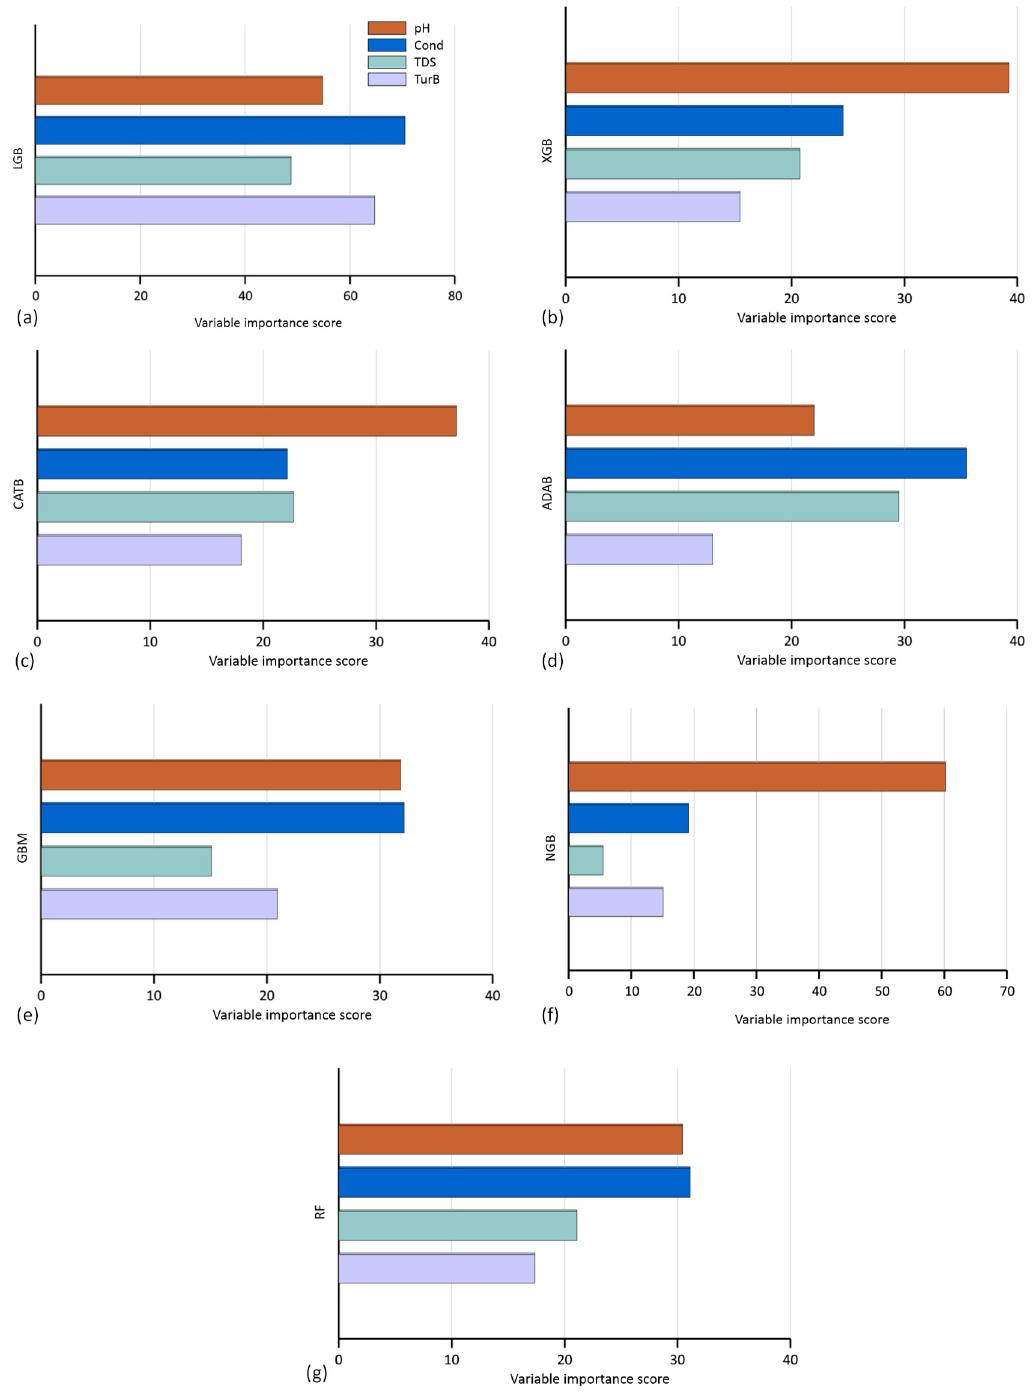
Figure 6. Assessment of input variable importance score using: ( a ) LGB; ( b ) XGB; ( c ) CATB; ( d ) ADAB; ( e ) GBM; ( f ) NGB; and ( g ) RF.